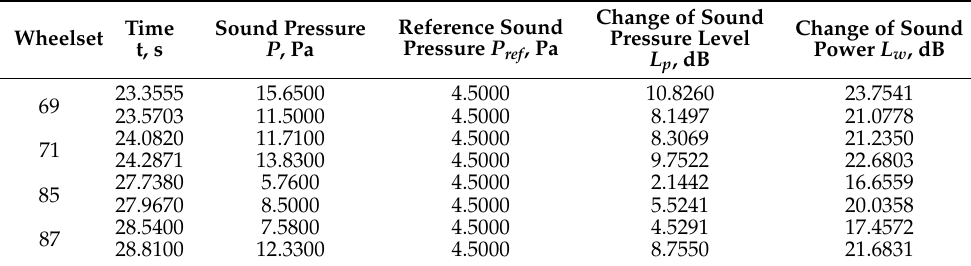
Table 7. Experimental results.